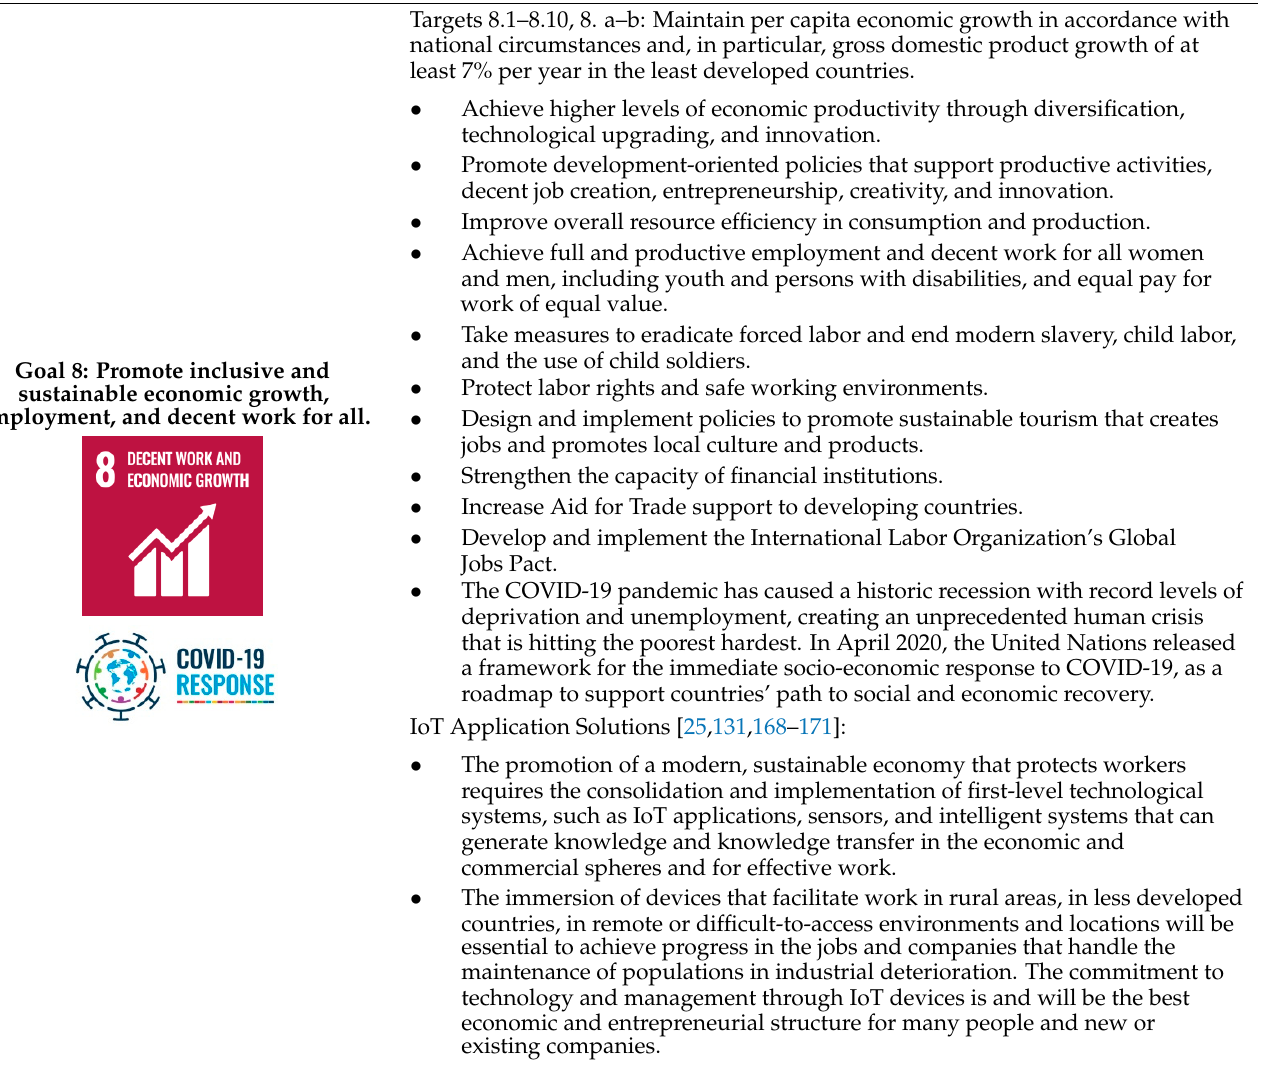
Table 5. Impact of the Sustainable Development Goals on IoT applications for improving health and the environment.